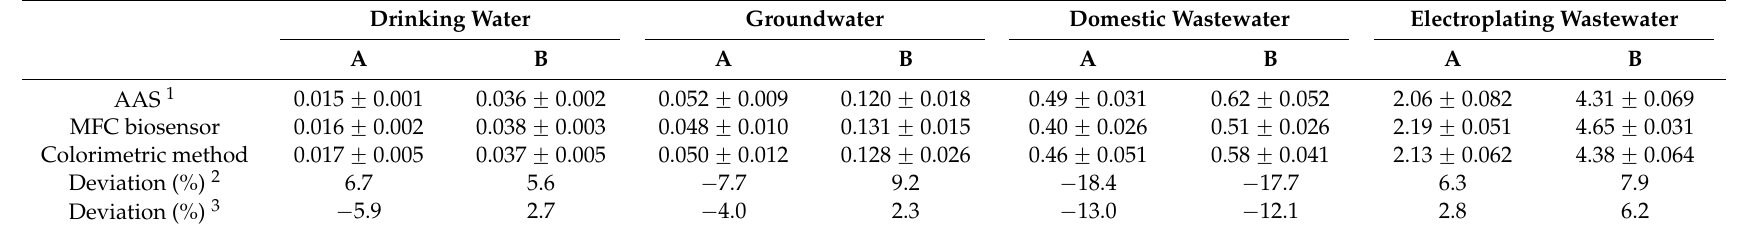
Table 2. Cr(VI) measurement from real wastewater by atomic absorption spectroscopy, MFC biosensor, and colorimetric method. Drinking